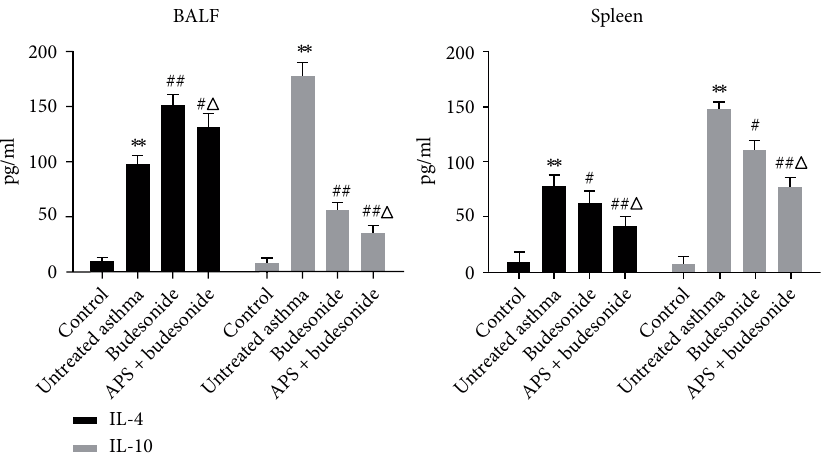
𝑃 < 0.05 , compared with budesonide group. △